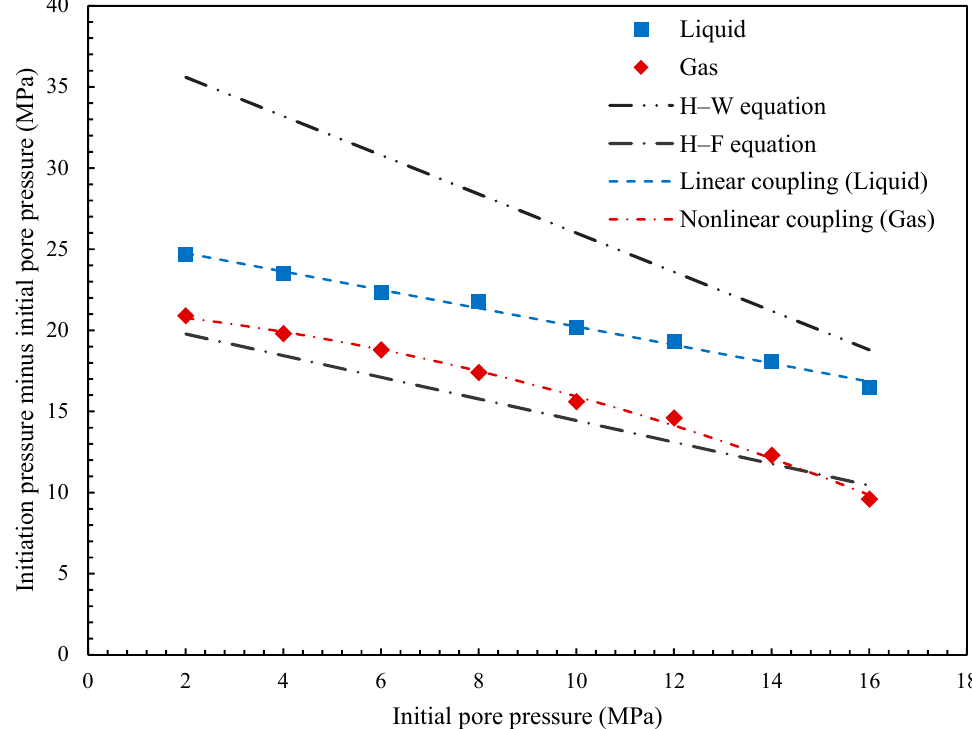
Figure 12. Relationship between initiation pressure and initial pore pressure.